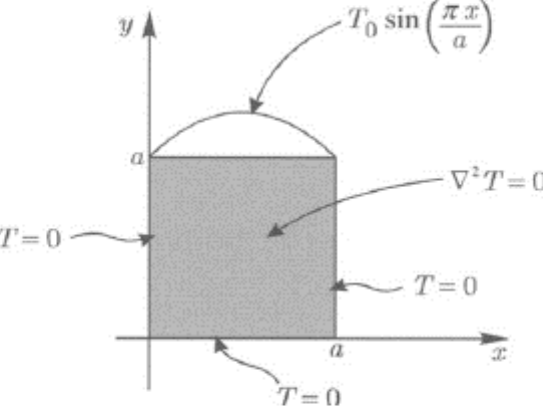
Figure 1 . Plate subjected to boundary